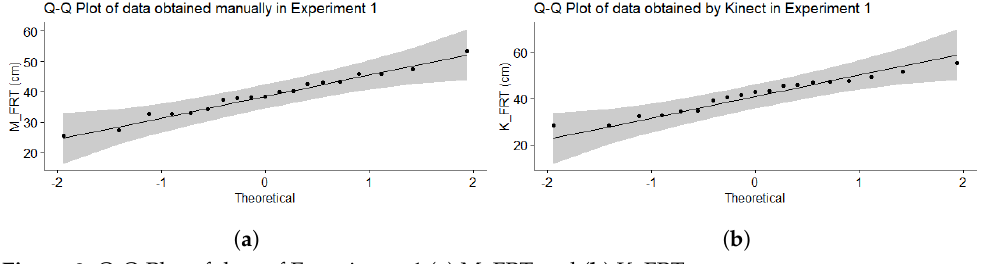
Figure 8. Q-Q Plot of data of Experiment 1 ( a ) M_FRT and ( b ) K_FRT.